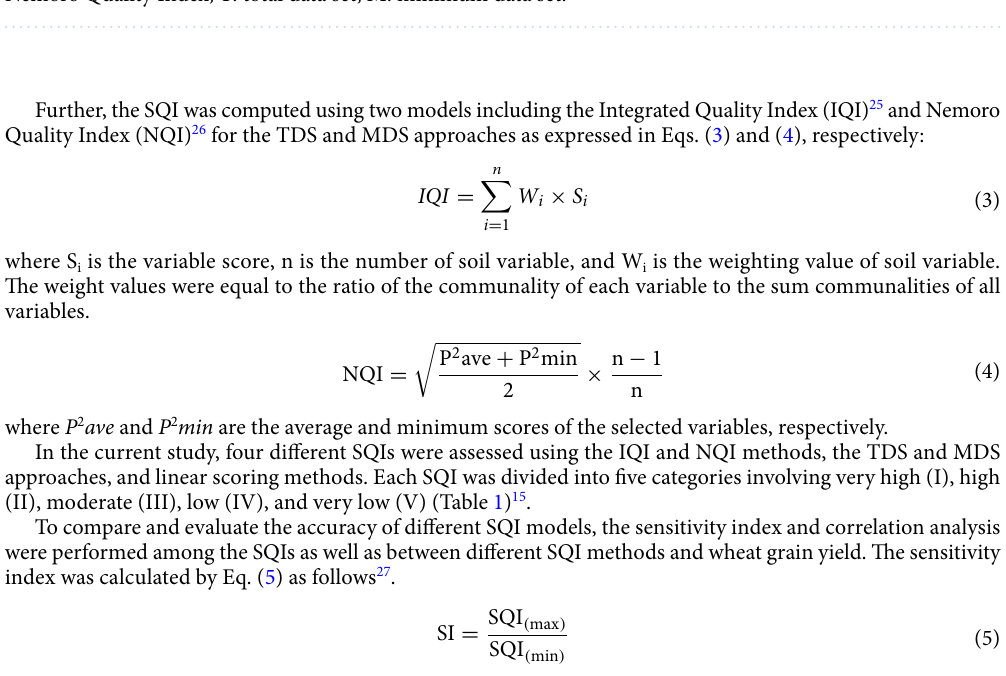
Table 1. Categorization of soil quality grades using different methods. IQI: Integrated Quality Index; NQI: Nemoro Quality Index; T: total data set; M: minimum data